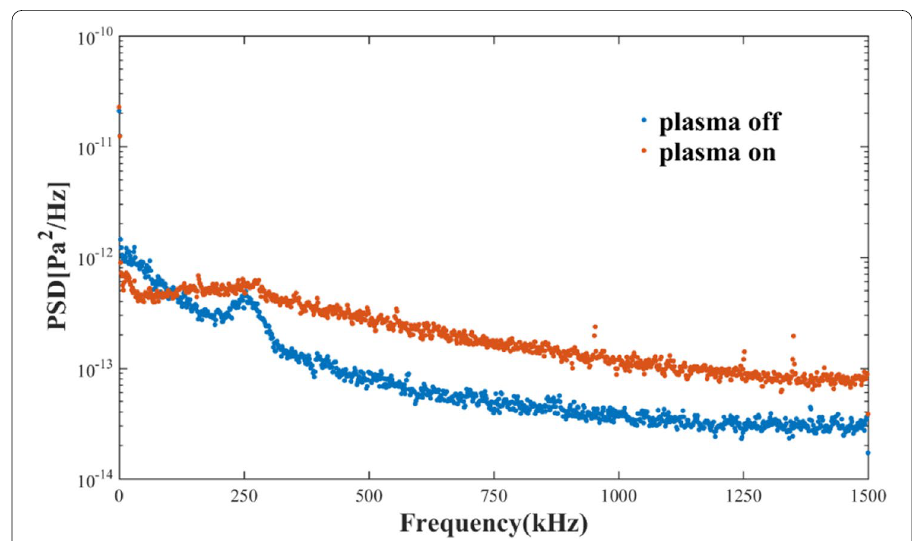
Fig. 26 The distribution of power spectral density of modal wave in a certain flow